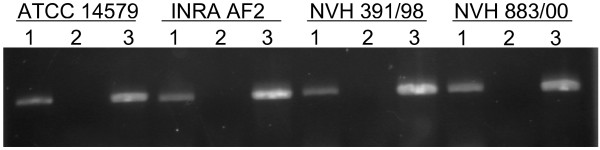
Detection of yvfTU expression by RT-PCR. Reverse transcriptase (RT) PCR experiments performed on the yvfTU operon of B. cereus strains ATCC 14579, INRA AF2, NVH 391/98, and NVH 883/00. The operon encodes the YvfTU two-component system. Lanes 1: RT-PCR on 500 ng RNA. Lanes 2: Negative control (RT-PCR on 500 ng RNA with a heat-inactivated reverse-transcriptase). Lanes 3: Positive control (PCR on 200 ng genomic DNA). The ~700 bp PCR product covered the 3'-region of yvfT running into the 5'region of yvfU, indicating that these two genes were expressed in a single operon.